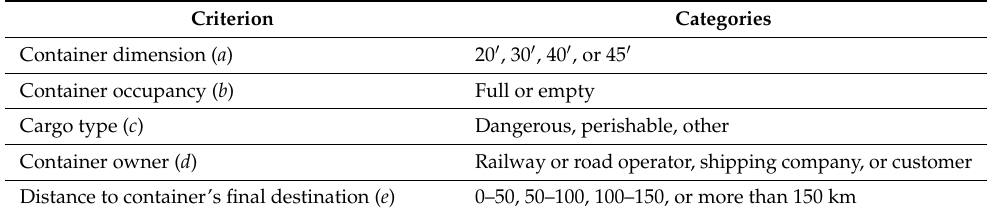
Table 1. Storage criteria for containers in the inbound zone at the 11 European inland terminals analyzed.